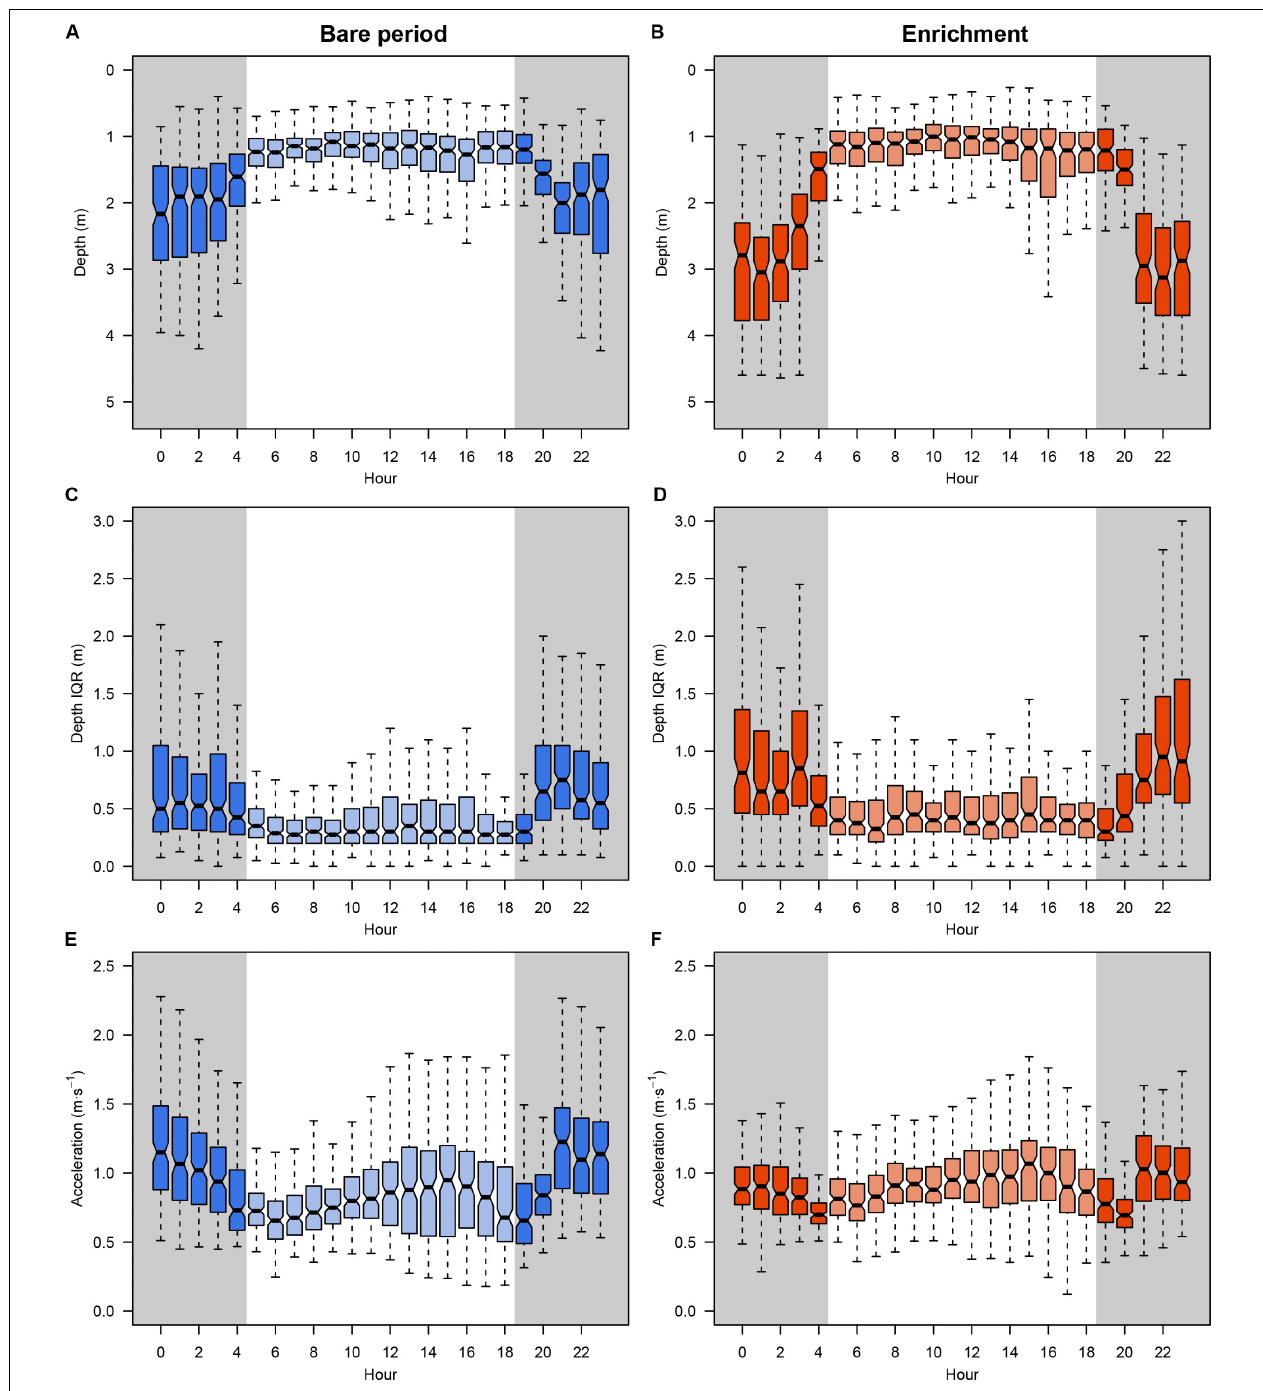
FIGURE 2 | Daily behavioral patterns of tagged gilthead seabream ( N = 10) during the experiment: overall distribution of depth values during bare (A) and enriched (B) period; IQR depth distribution during bare (C) and enriched (D) period; and overall distribution of acceleration values during bare (E) and enriched (F) period. Boxes represent the interquartile range and the inside bar is the median. The lines extend to the maximum and minimum values.